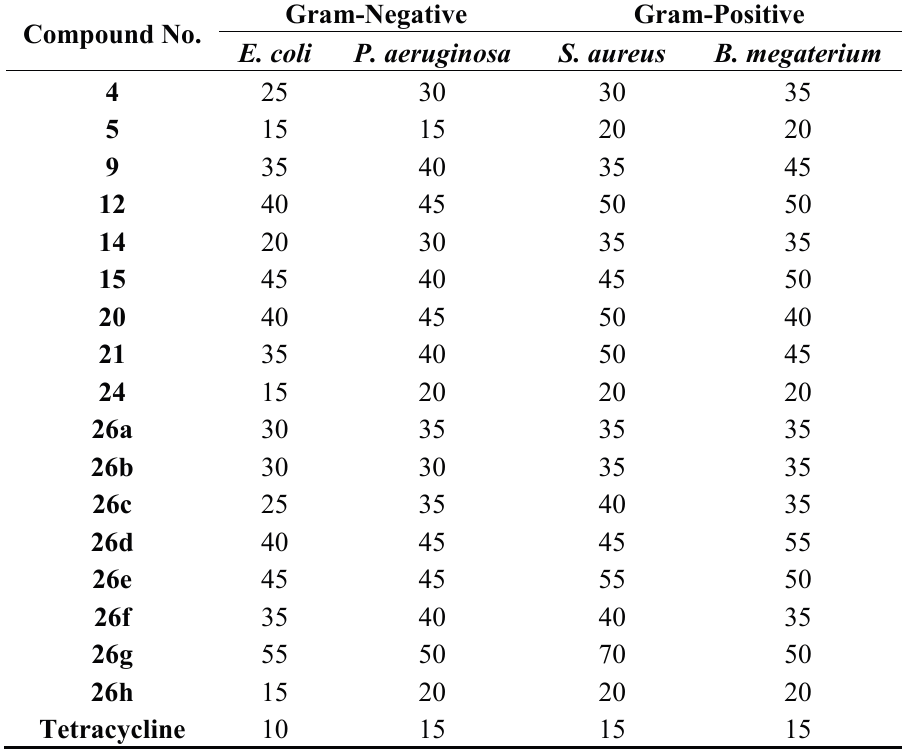
Table 2. Minimum inhibitory concentration ( μ g/mL) of compounds against Gram-negative and Gram-positive